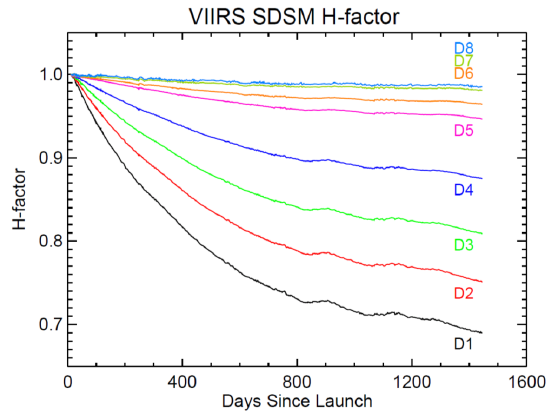
Figure 2. H-factors for SDSM D1–D8 determined by Equation (5). The H-factors are normalized to the satellite launch date.